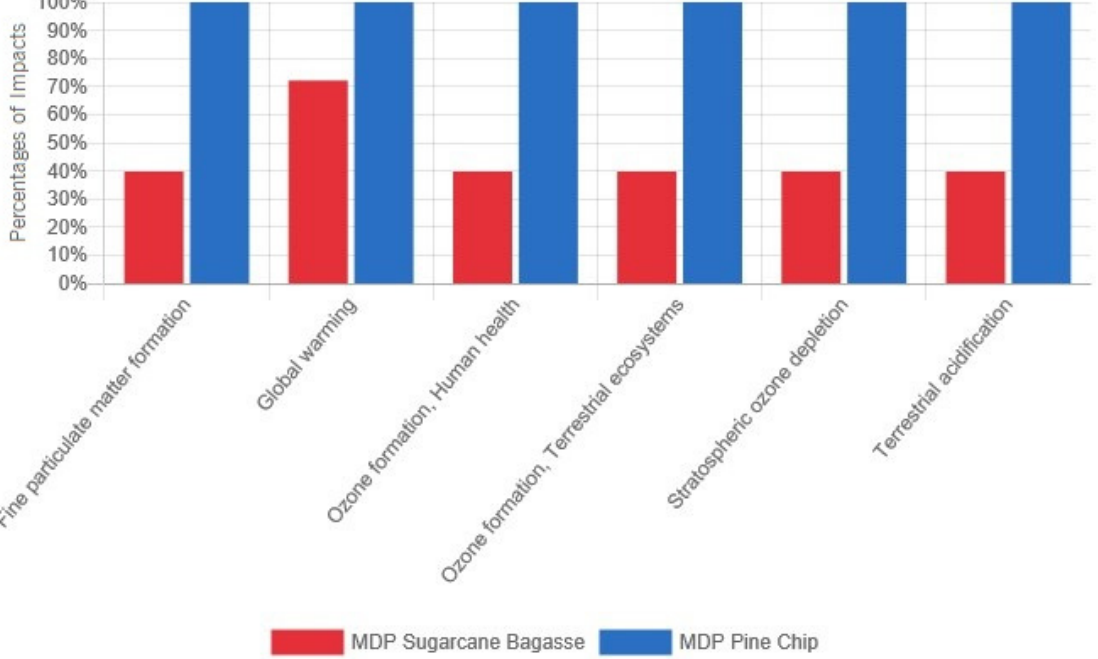
Figure 3. Representation of the relative percentages of the impacts generated.